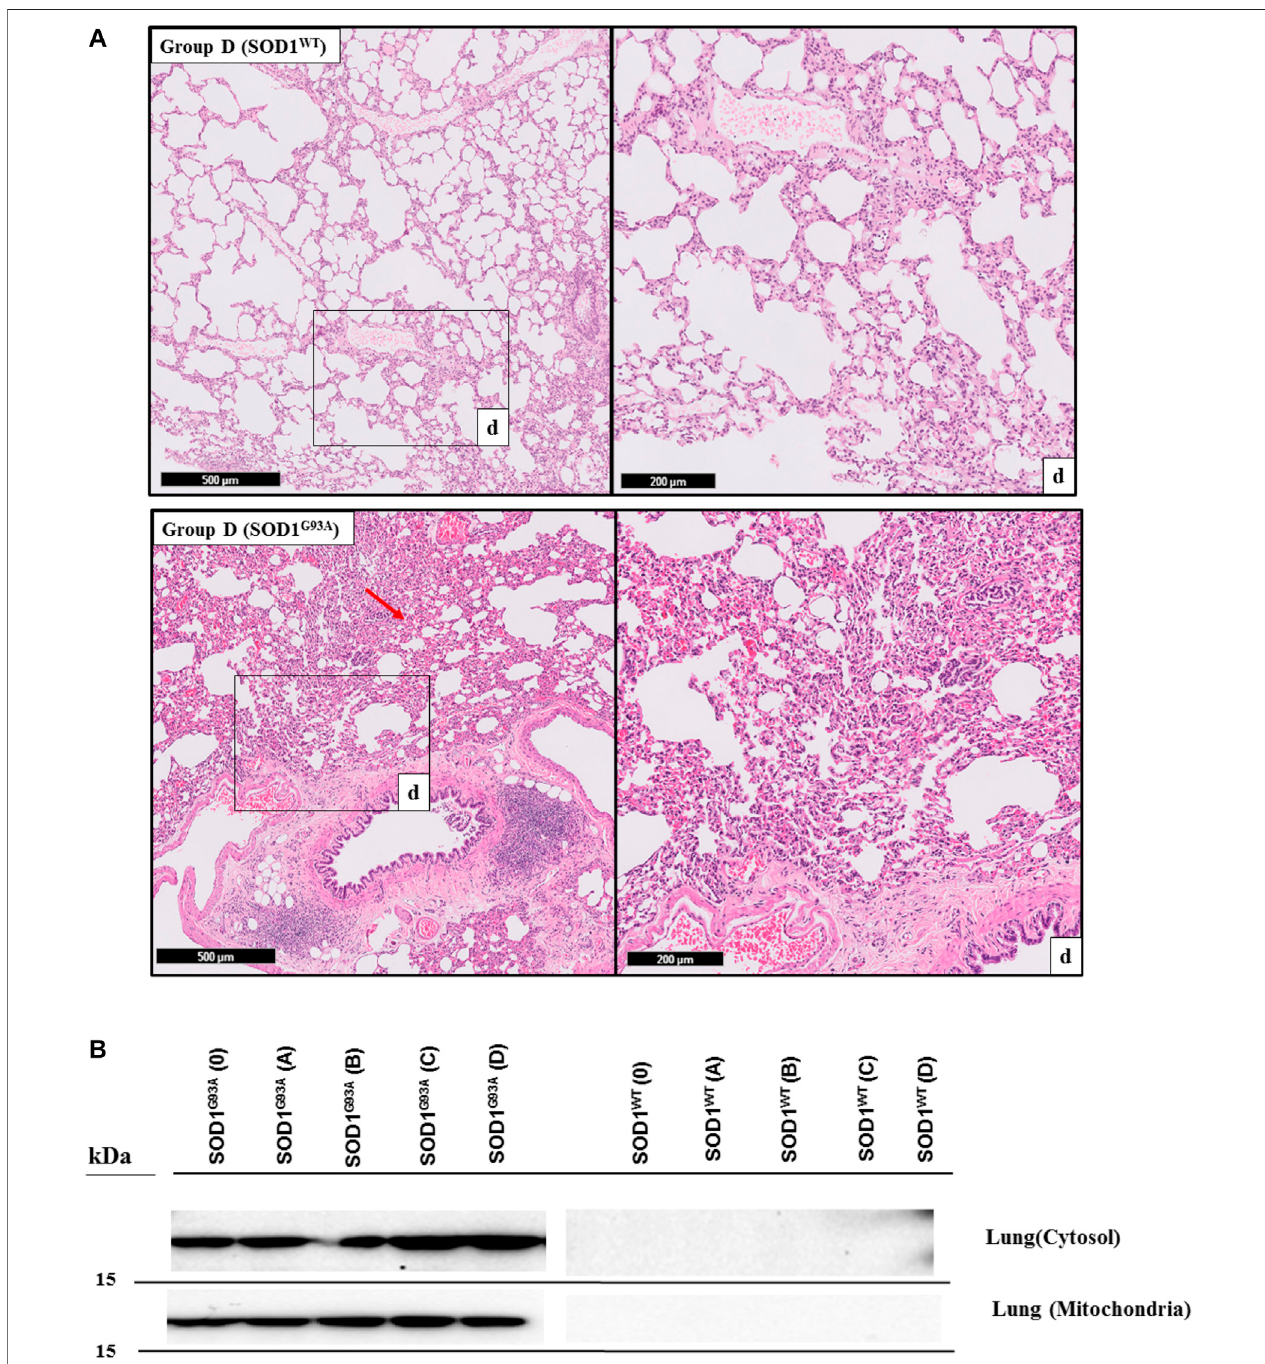
FIGURE5| H&E-stained sections ofthe lung tissue samplesbelongingtothe SOD1 WT and SOD1 G93A ratsofgroup D. All lung tissues ofrats( n =90) werestained and evaluated; among them, representative images were taken from each group. Scale lines on the left row indicate 500 μ m and the second row 200 μ m. Red arrows indicatetheareawithatelectasisandemphysemaofSOD1 G93A rats(A).SOD1 G93A proteinaccumulationwasevaluatedinthecytosolicandmitochondrialfractionsofthe lung tissue. Accumulation of human mutant SOD1 G93A has been found in all SOD1 G93A groups, where SOD1 WT did not show any mutant protein in the lung tissue (B).